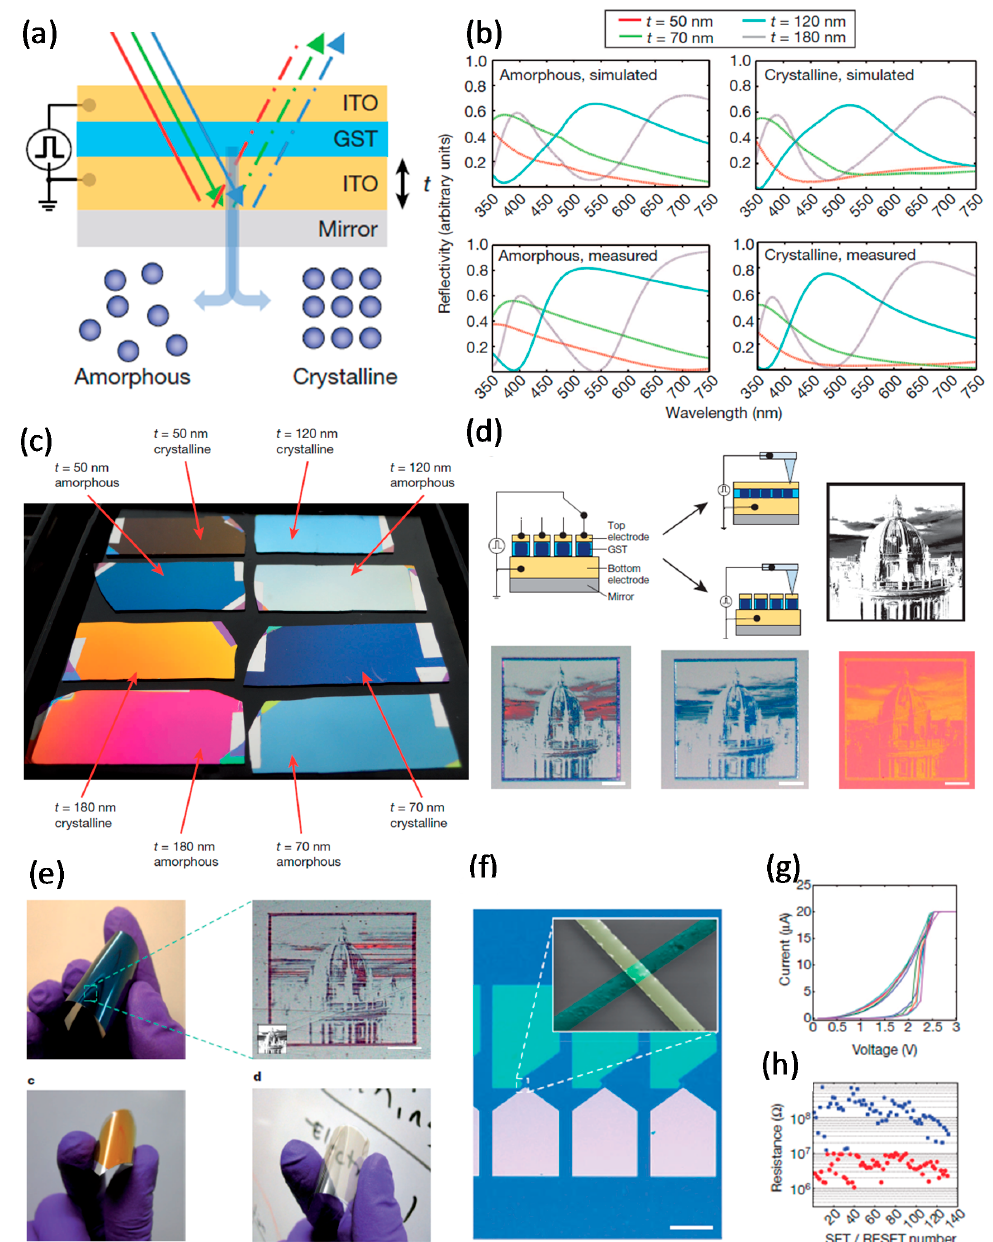
Figure 8. Color generation tunable metadevices. ( a ) Representation of a thin film pack with GST layer sandwiched between two ITO films; ( b ) Reflectivity spectra for amorphous and crystalline phases of GST with simulation (top part) and measurement (bottom part); ( c ) An illustrative example of four various films with Pt/ITO/GST/ITO structure and different thickness of ITO ( t ), which defines the reflective color; ( d ) Electrical alteration of the color and reconstruction of the patterned image using CAFM; ( e ) The flexibility of the reflective display on a plastic substrate. ( f ) An optical image of the crossbar device; ( g ) I – V curve of the electrically switchable device; ( h ) More than 100 set/reset cycles of the fabricated crossbar device. Adapted from [10], with permission from © 2014 Nature Publishing Group.